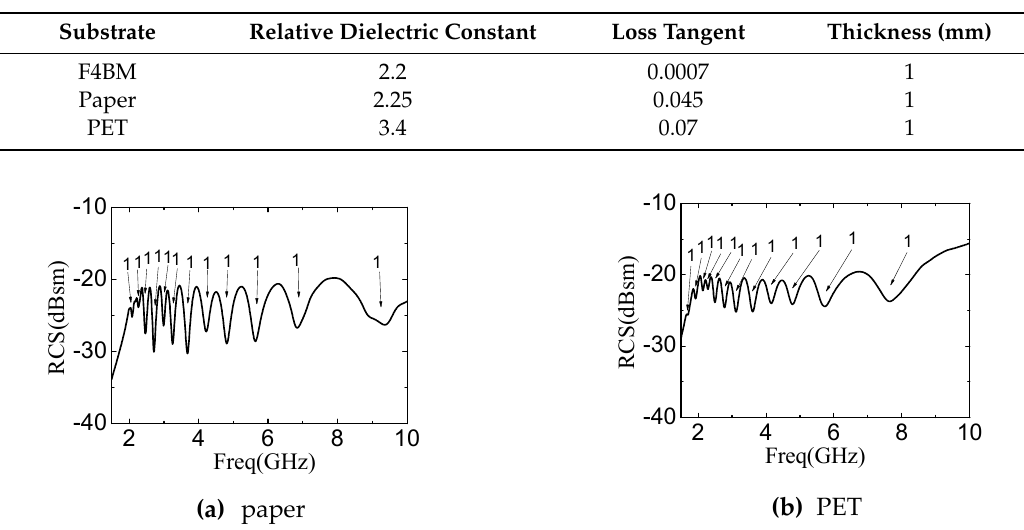
Figure 16. The simulation spectra of the twelve rectangular slot rings when the substrates are paper and PET, respectively.